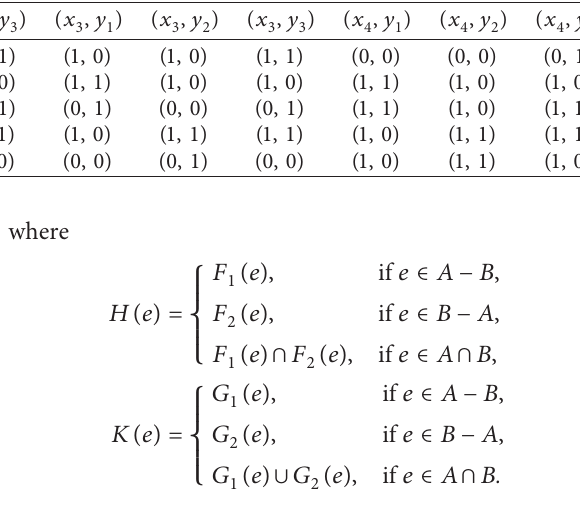
Table 2: Tabular form of the T-bipolar soft set ( F,G,A )